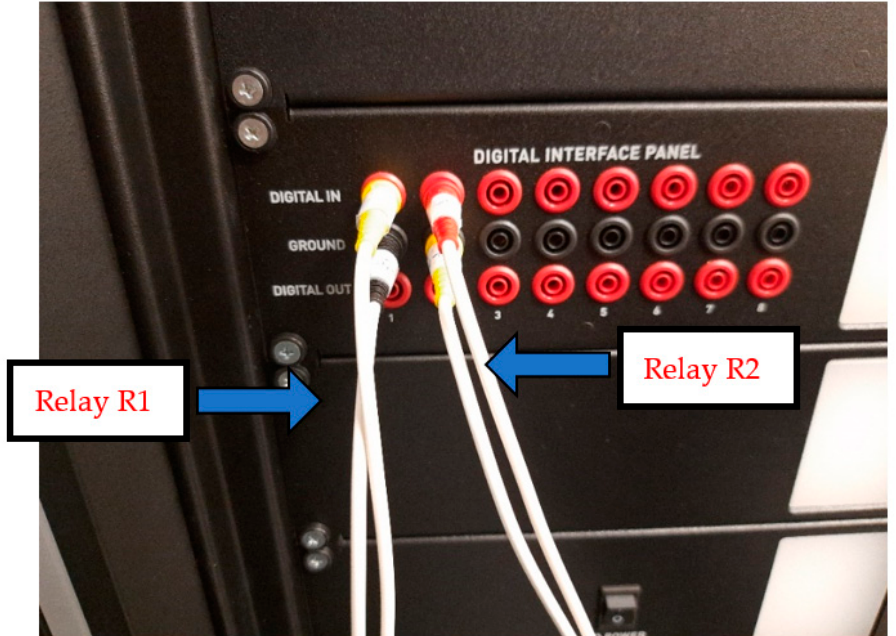
Figure 18. Digital interface panel of RTDS receiving signal from relay.